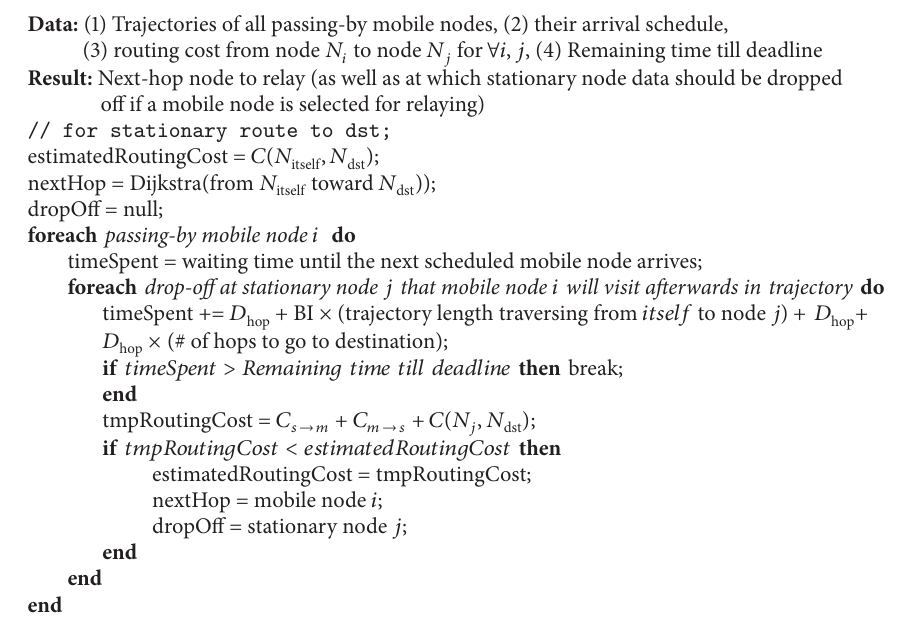
Algorithm 1: Greedy data transportation algorithm.